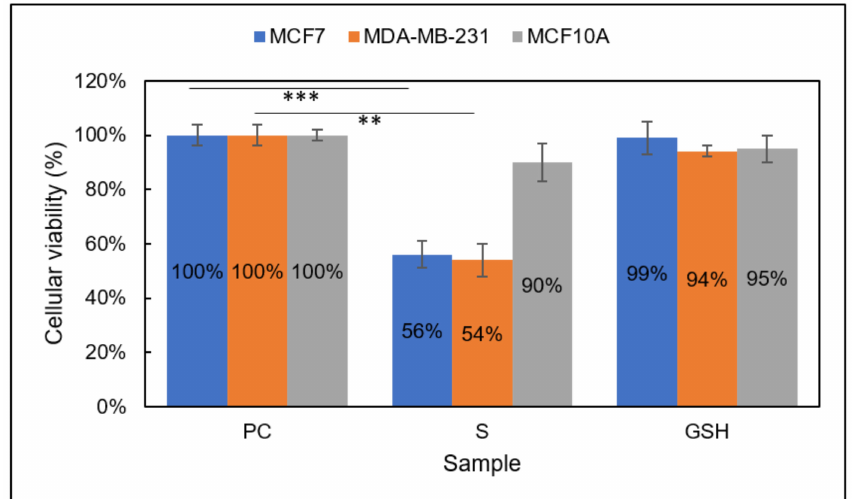
Figure 5. Cellular viability of MCF7 (blue), MDA-MB-231 (orange), and MCF10A (gray) cells analyzed using the CTB assay. Sample groups include: PC (untreated), S (Group 2), and GSH (functional control) cells analyzed with the CTB assay. Data points represent the mean ± standard deviation. Statistical differences from the positive control are represented by ** p < 0.01, *** p <